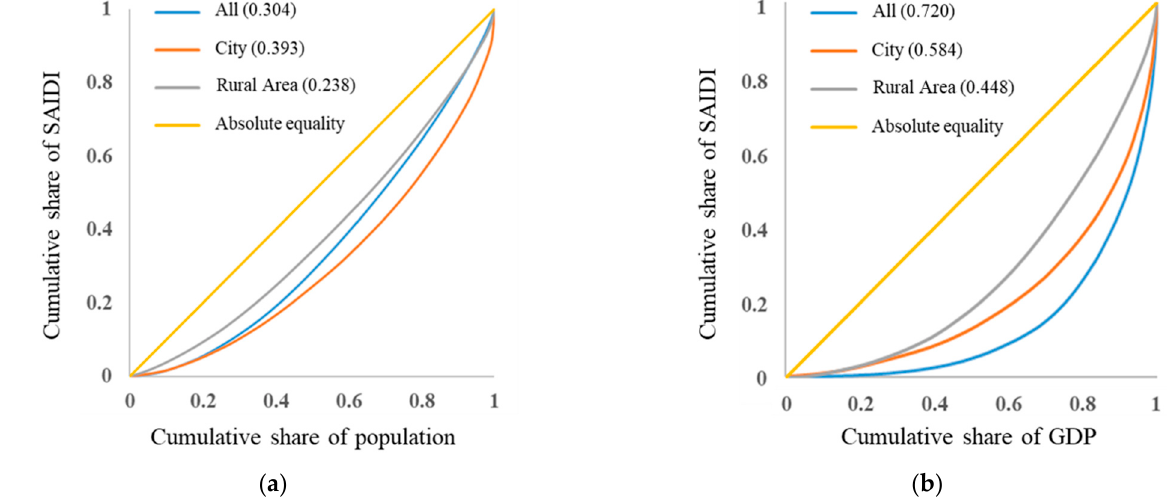
Figure 2. Lorenz curves of ESQ (SAIDI) in China. ( a ) Lorenz curve with cumulative share of population on the horizontal axis. ( b ) Lorenz curve with cumulative share of GDP on the horizontal axis.